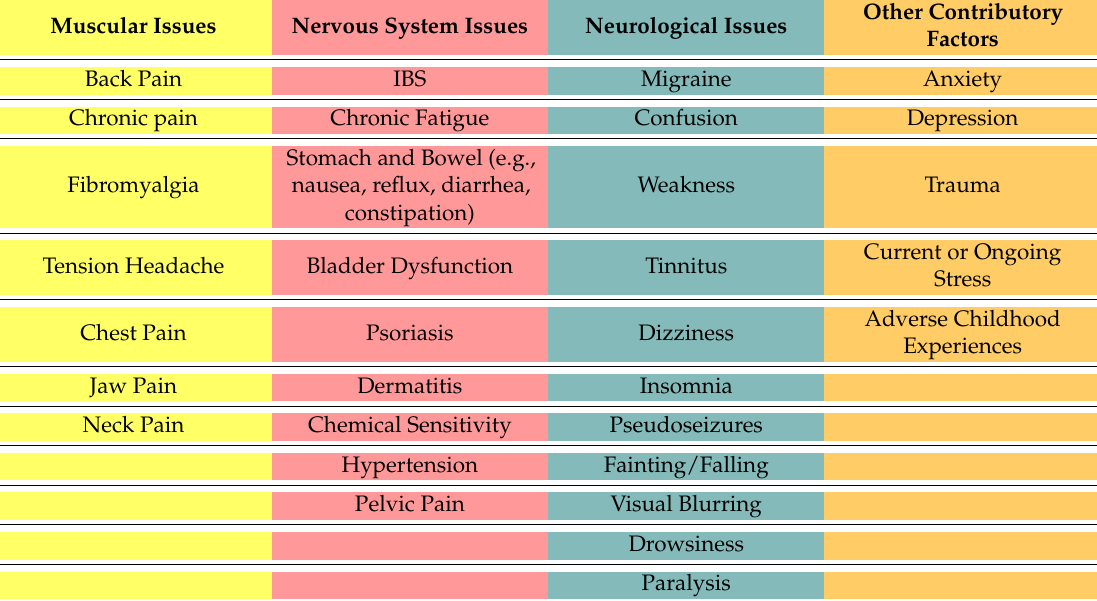
Table A4. Anxiety Pathways and Associated